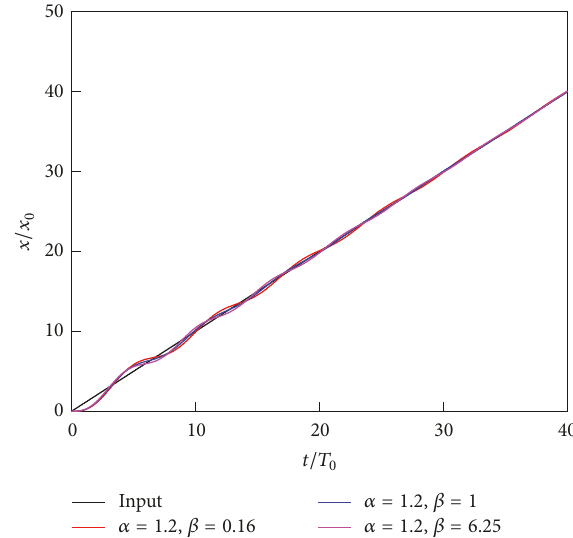
Figure 24: Response in the time domain ( 𝛼 = 1.2, 𝛽 = 0.16, 1, 6.25 Ω is normalized 0 ,